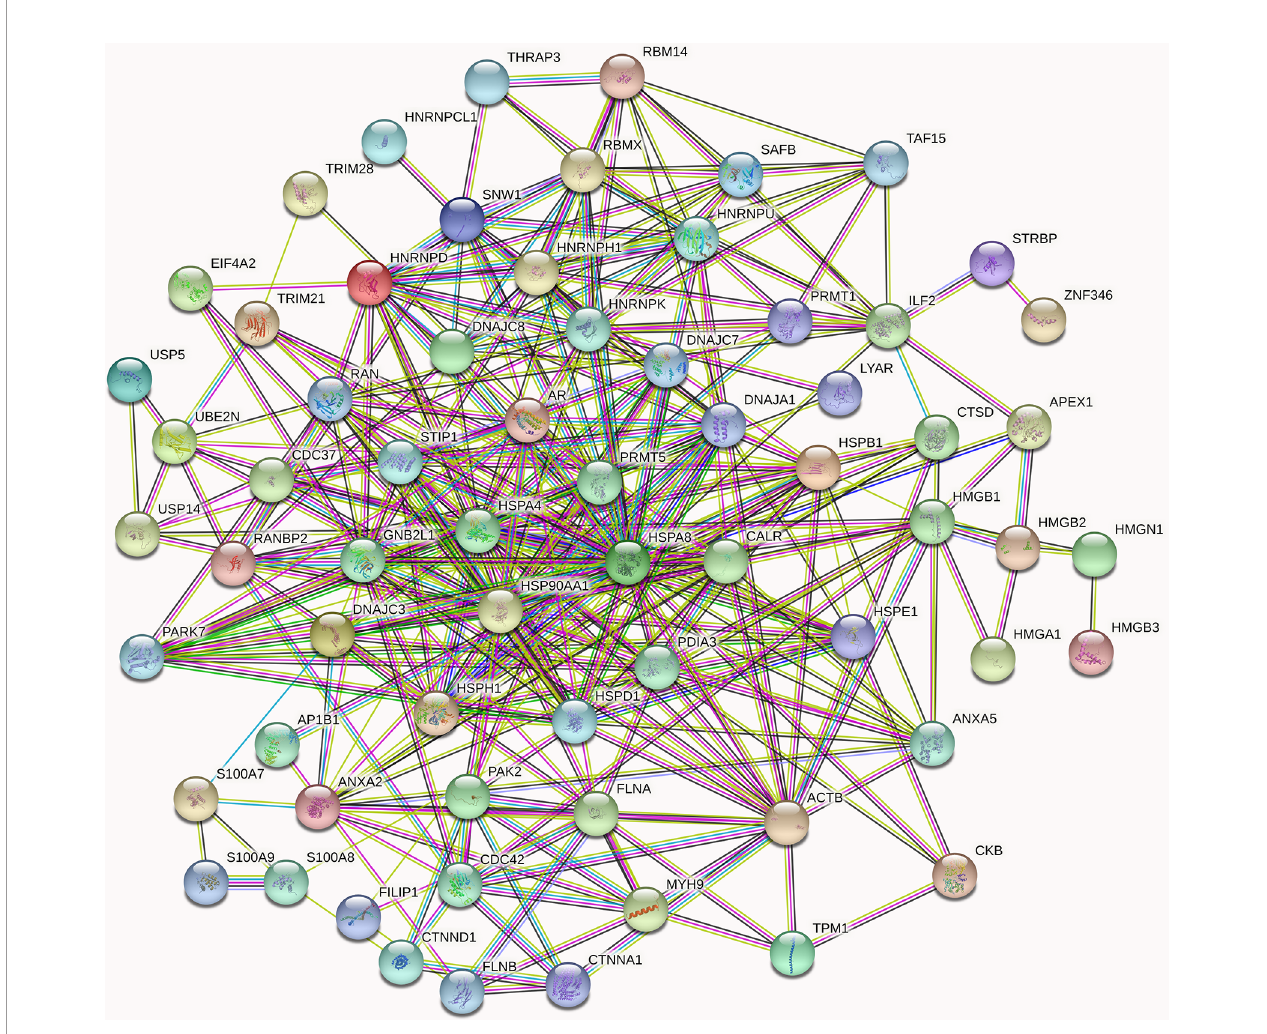
FIGURE 5 | High-con fi dence protein-protein interaction network of already reported and AR new candidate coregulators. Overall, 67 proteins listed in Supplementary Table 1 are involved in the AR signal networks. In the networks, links between proteins signify various interaction data supporting the network, colored by evidence type (see STRING website for color legend). These proteins that directly interact with AR have been veri fi ed by other articles, while the indirect interactions are putative AR cofactors. The nodes in different colors represent different